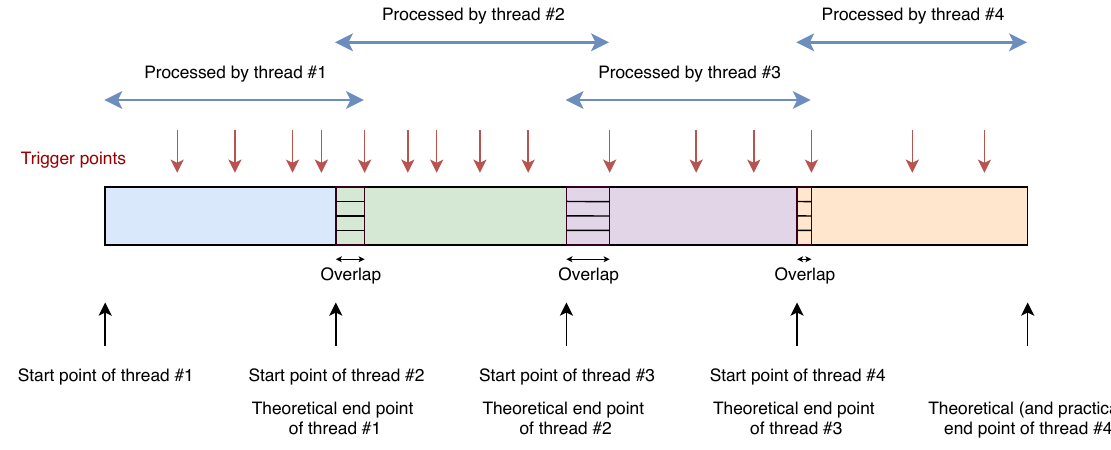
Figure 2. Representation of the multi-thread